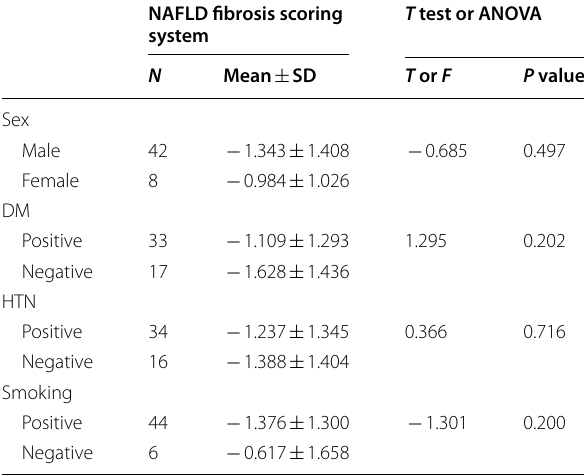
Table 7 Relationship between average EAT thickness and sex of the patients and their